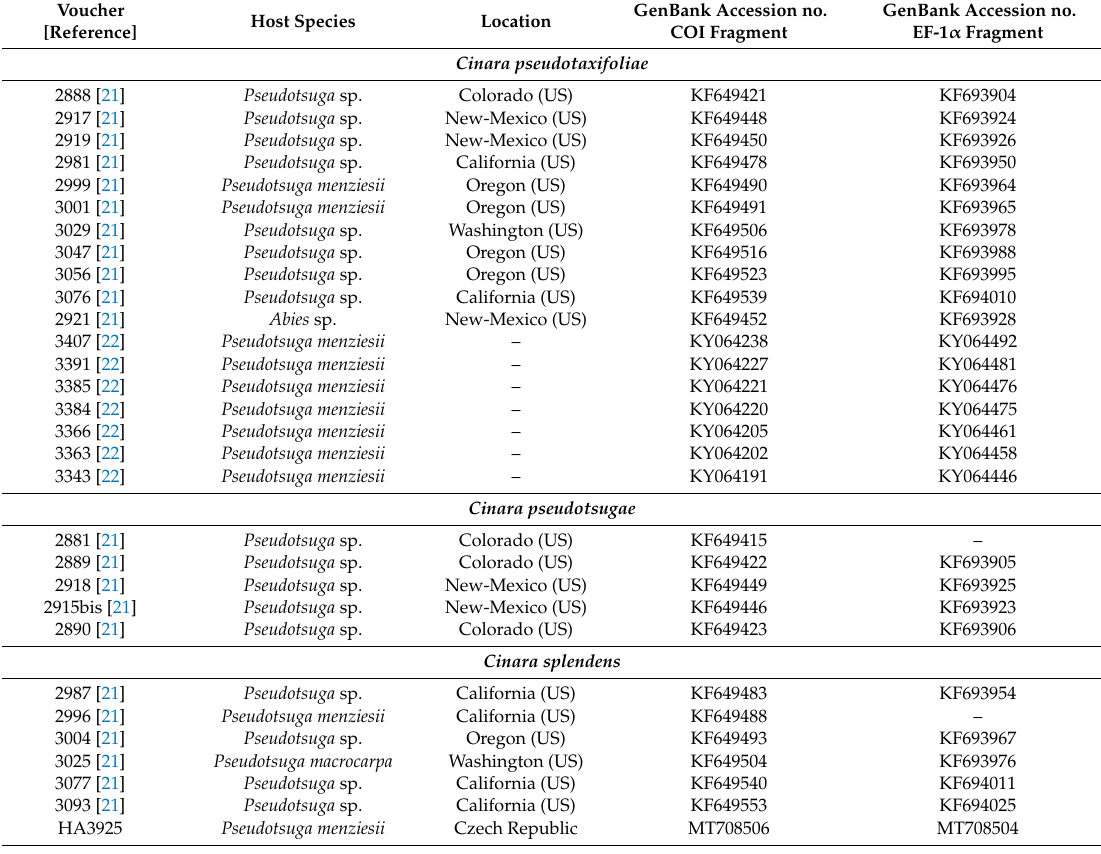
Table 2. Partial COI and EF-1 α sequences of Cinara spp. from Pseudotsuga